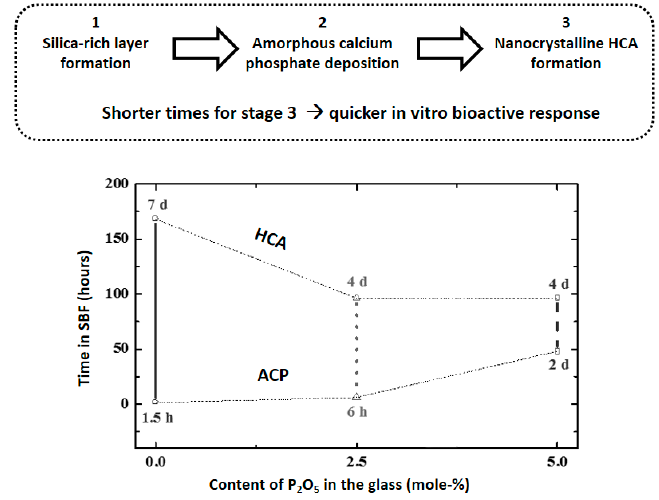
Figure 3. Top : Main outcomes after soaking a BG in SBF. Bottom : The times required for stages 2 and 3 for three silica ‐ based sol ‐ gel glasses containing, respectively, 0, 2.5 and 5.0 mol ‐ % P 2 O 5 .